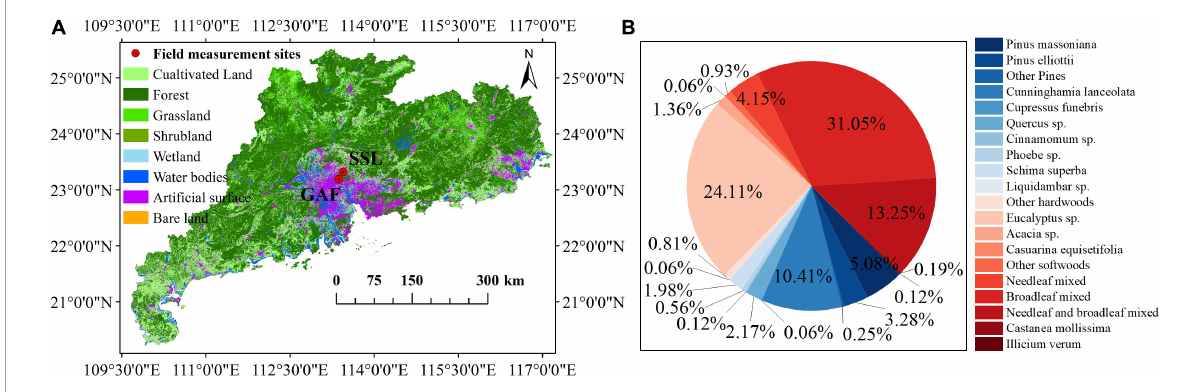
FIGURE1 The locations of field campaigns. GAF and SSL are the abbreviations of the Guangdong Academy of Forestry (GAF, 23.195 ◦ N, 113.374 ◦ E) and Song Shu Ling (23.322 ◦ N, 113.450 ◦ E), respectively; Land cover data were downloaded from http://www.globallandcover.com/ (A) ; and the coverage (%) of dominant trees in Guangdong Province. Data were obtained from http://www.forestdata.cn (B) .